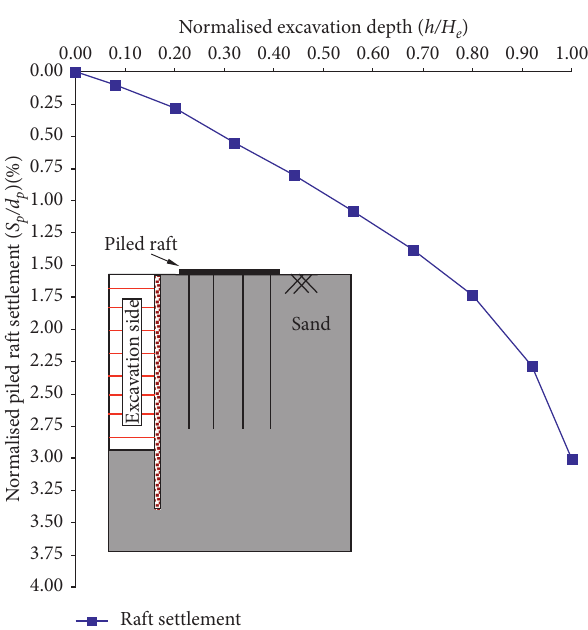
Figure 6: Piled raft settlement during